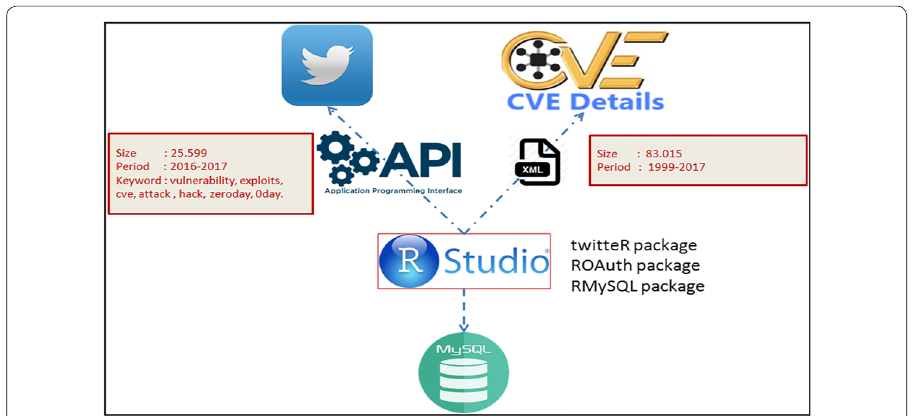
Fig. 1 Data sources and software relation: This figure explain how we collected the data coming from Twitter and CVE using Statistical software R. The data collected then supplied for the next process to